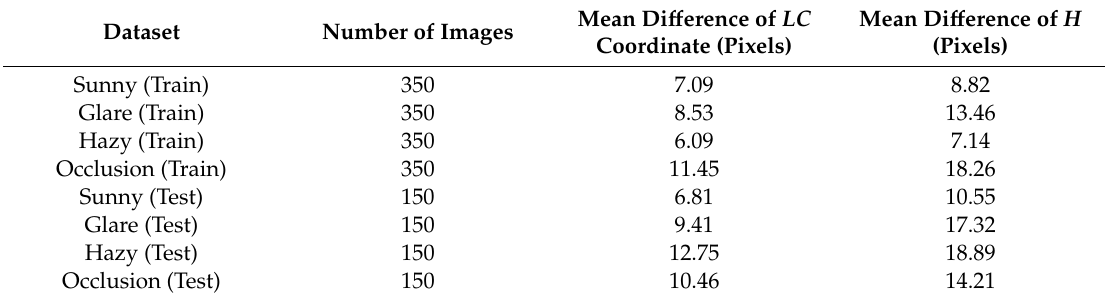
Table 5. Location estimated accuracy of camera motion attitude